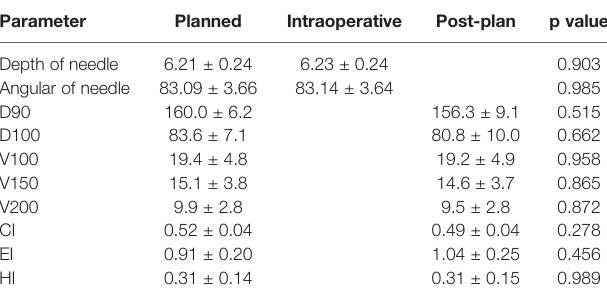
TABLE 2 | Analysis of pre-planning and intraoperative/post-plan parameters. Parameter Planned